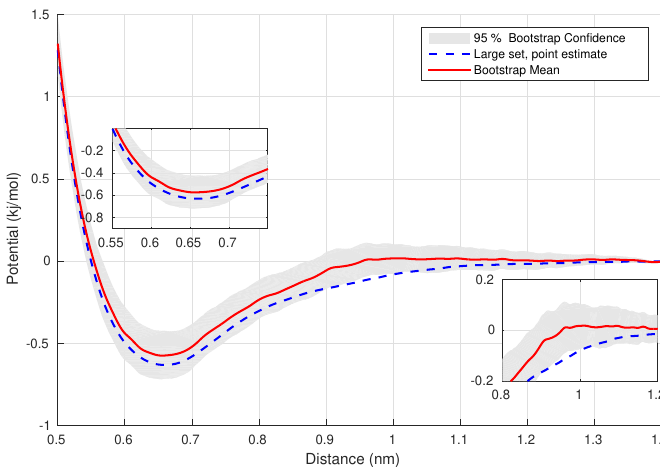
Figure 4. Polyethylene: The FM potential for linear B-splines, for a set of 5000 observations and the 95% Bootstrap Confidence interval for the FM potential, with a set of 300